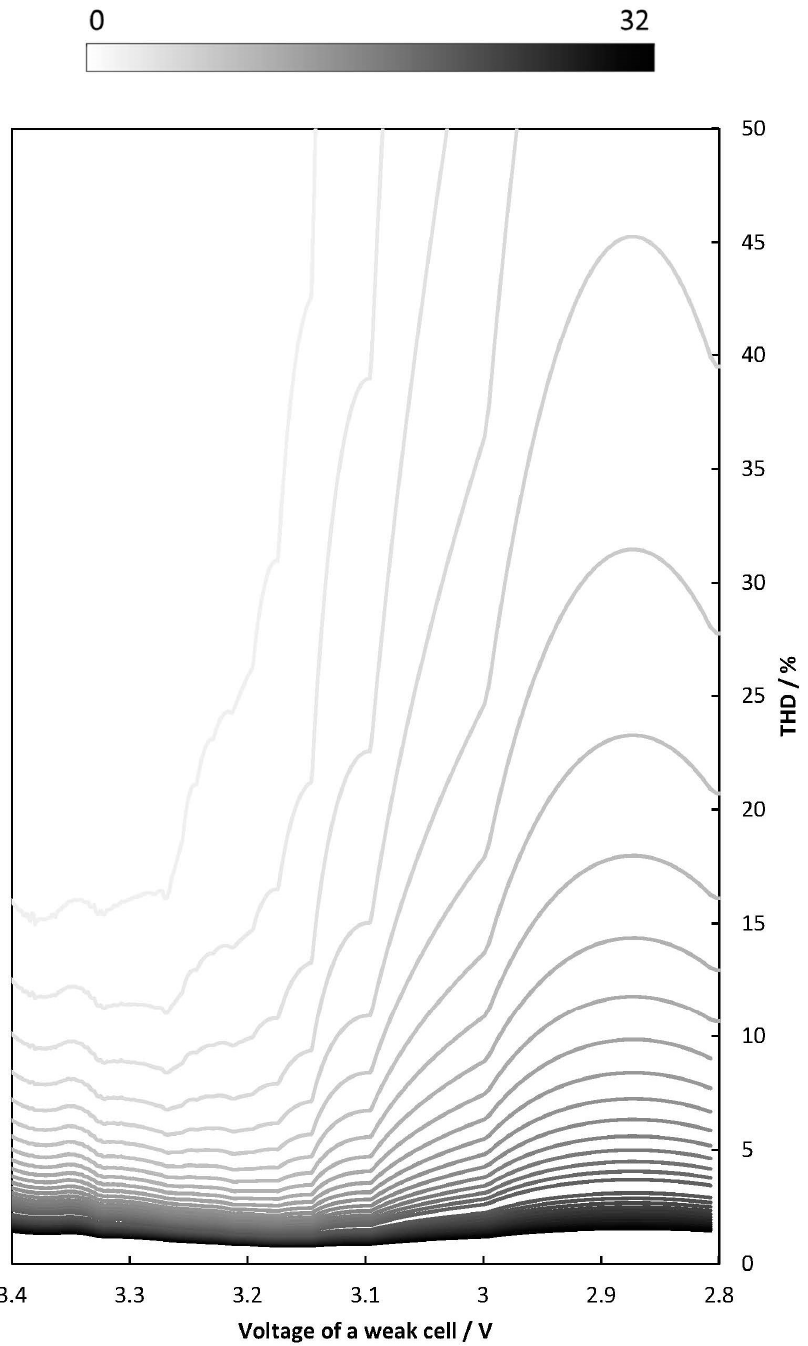
Figure 10. Simulated THDs while battery packs with 2 to 32 cells connected are discharged.